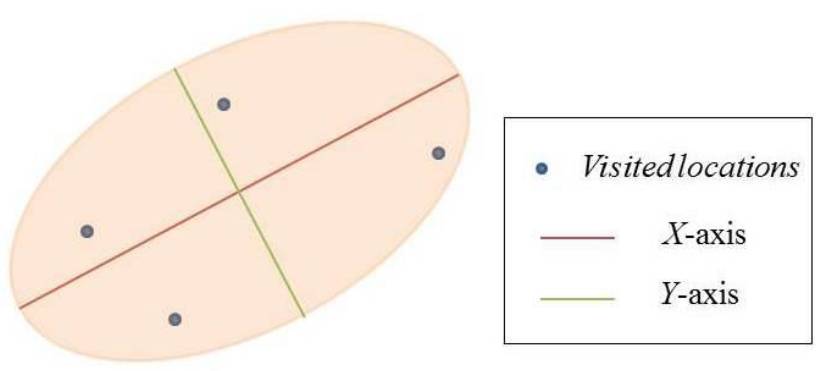
Figure 2. SDE of an individual’s daily